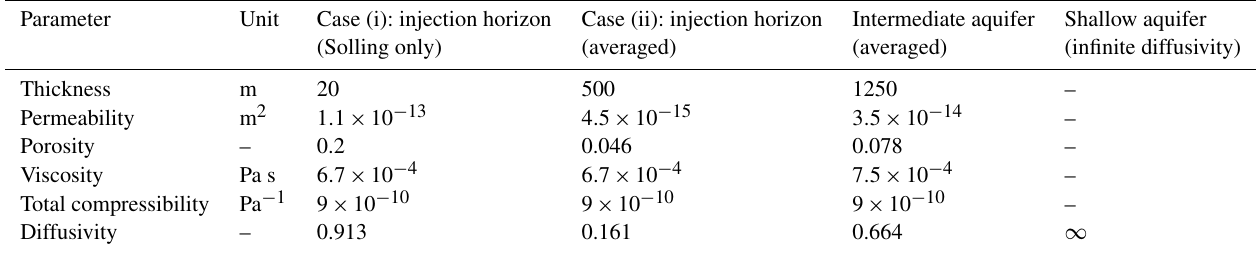
Table B1. Values for the permeability, porosity, viscosity, and diffusivity of the injection horizon, the intermediate aquifers, and the shallow aquifers for the Analytical Model. For the injection horizon, we differentiate between the two cases shown in Fig.